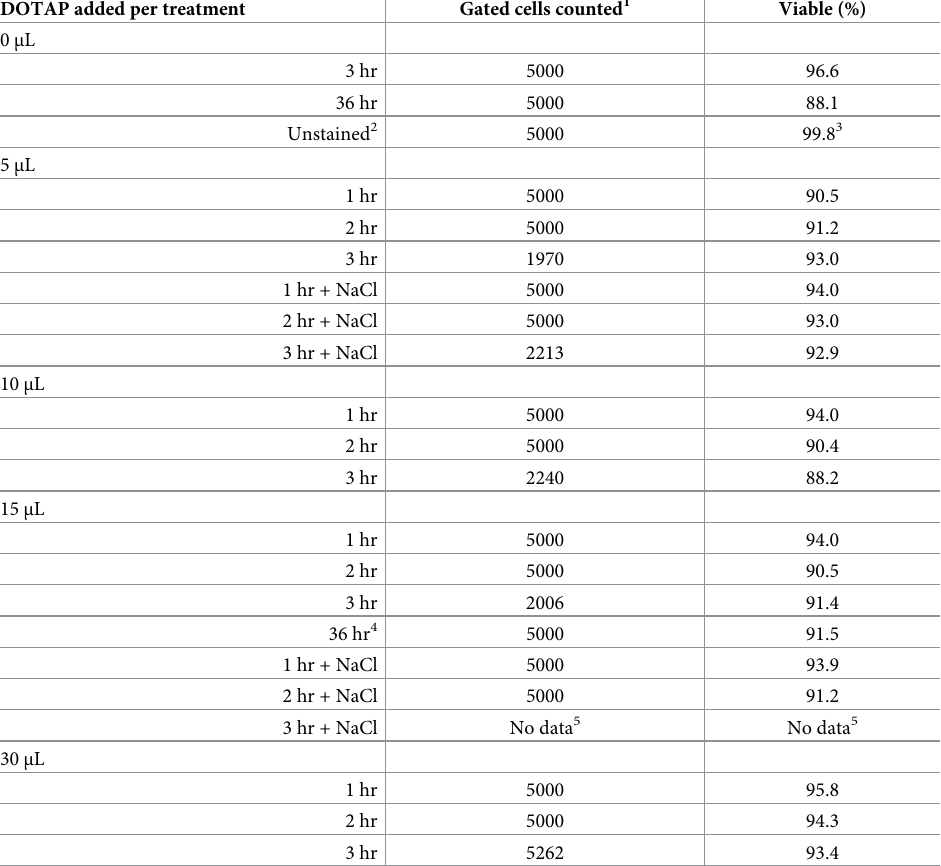
Table 1. Percent cell viability after treatment with